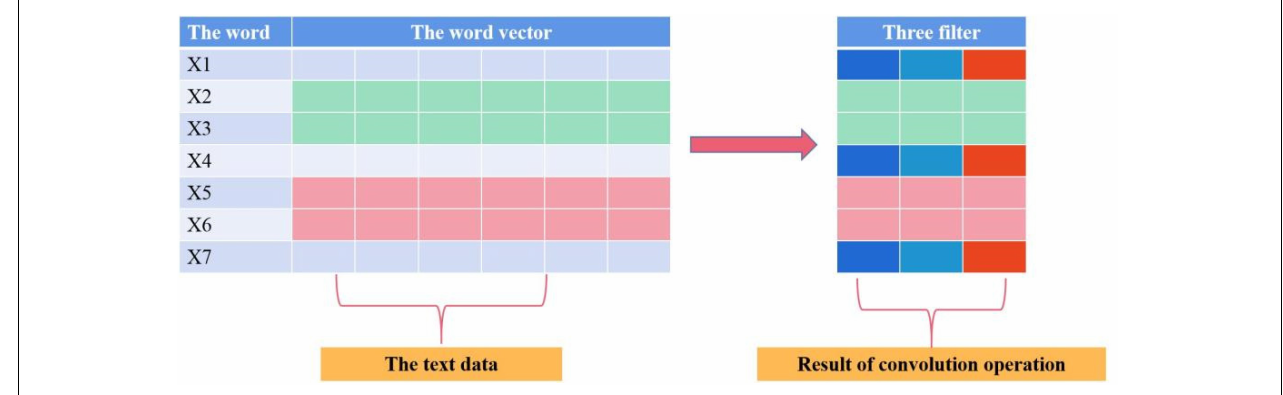
FIGURE 3 | Schematic diagram of the convolution operation.